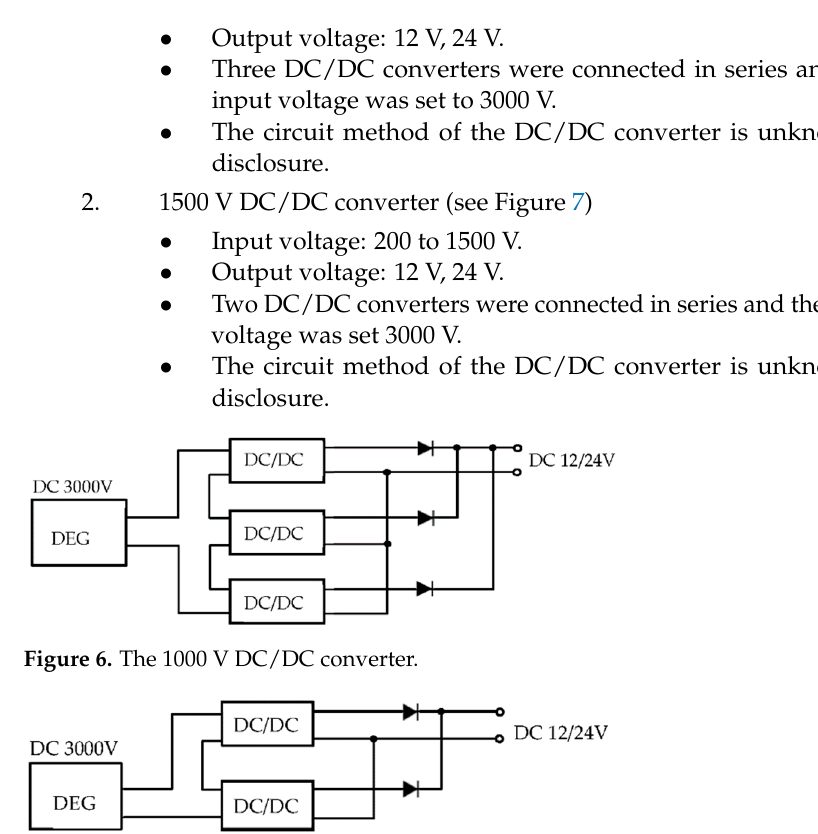
Figure 7. The 1500 V DC/DC converter.